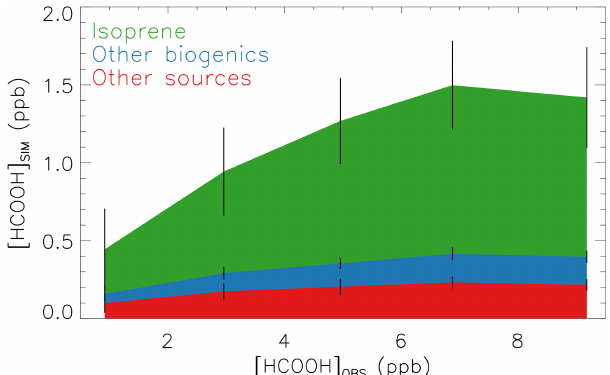
Figure 4. Simulated HCOOH binned and plotted as a function of the observed concentrations during the SENEX campaign over the US Southeast. Simulated values are shown as a stack plot, with HCOOH from the oxidation of isoprene (green), other biogen- ics (blue), and other sources (red) adding to give the total model amount. Vertical lines show the standard deviation of the simulated abundance in each